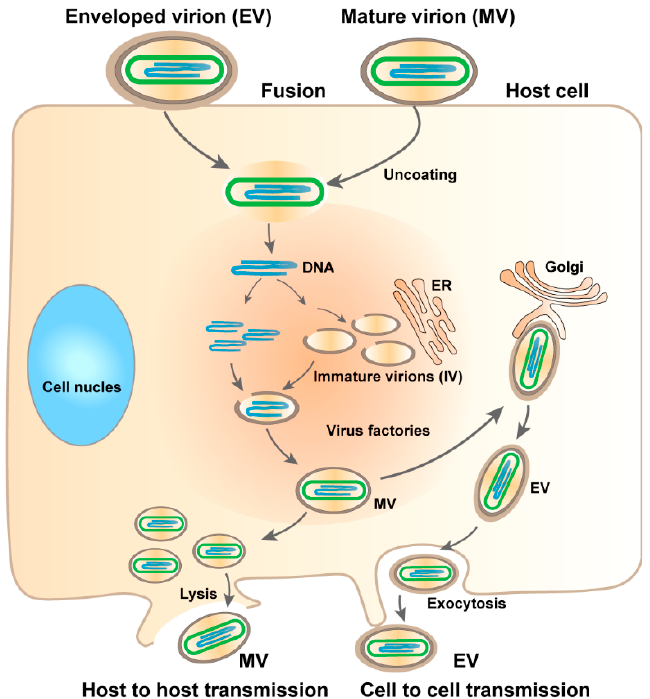
Figure 1. Life cycle of MPXV. EV enters the host cell by fusion and MV by micropinocytosis or fusion. Within the viral factory, immature virions (IVs) are assembled to form MVs. Some MVs are wrapped to form EVs. Virus exits via budding of EVs or by cell lysis to release MVs. Two distinct clades have been identified: the West African clade and the Central African clade. The case–fatality rate in Central Africa in the 1980s was about 10% in non- vaccinated individuals, while there were no fatalities in cases occurring in West Africa [10]. While MPVX generally does not show the large number mutations as seen in RNA viruses, such as SARS-CoV-2, isolates from the 2022 outbreak shared 40 mutations, well above the virus’ standard mutation rate [9]. Monkeypox is clearly less severe than small- pox, with lower mortality (recent case fatality ratio 3%–6%) compared with smallpox (30%) [11]. The genome of the MPXV shows over 96% identity to the VARV. Smallpox